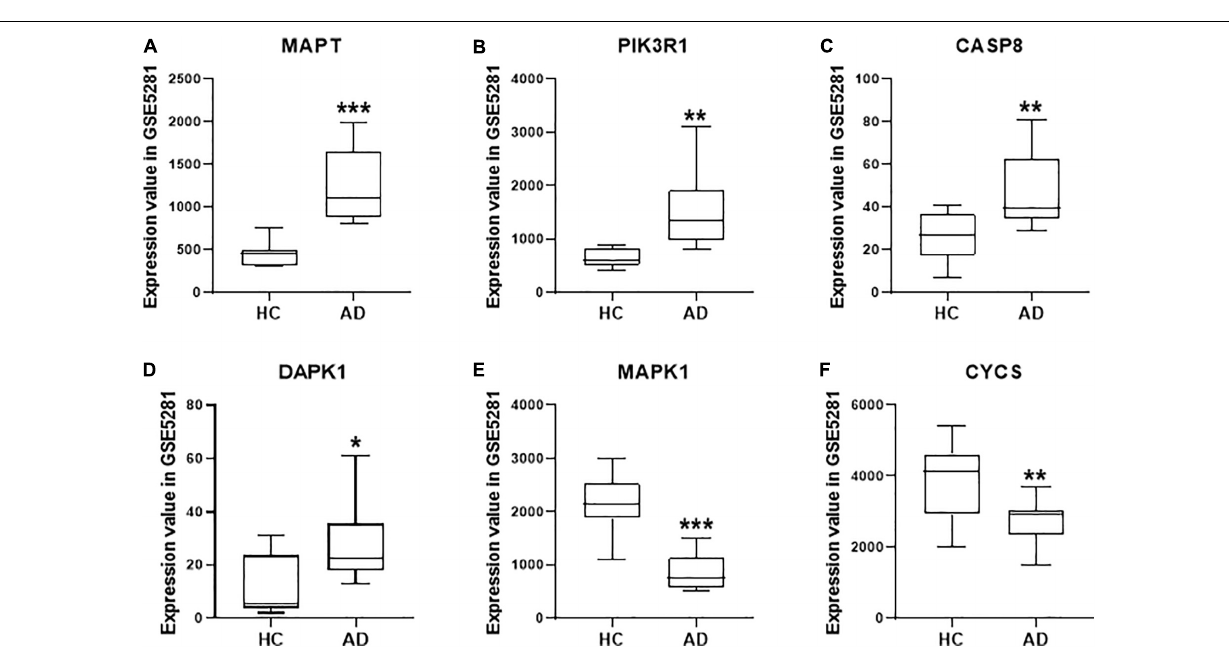
neurodegeneration (Braak et al., 1994; Balaji et al., 2018). In addition, the accumulation of MAPT in dendrites is a critical step in A β -induced neurotoxicity (Ittner et al., 2010; Zempel et al., 2010). In this study, we predicted and verified that the level of MAPT was significantly increased in the brain